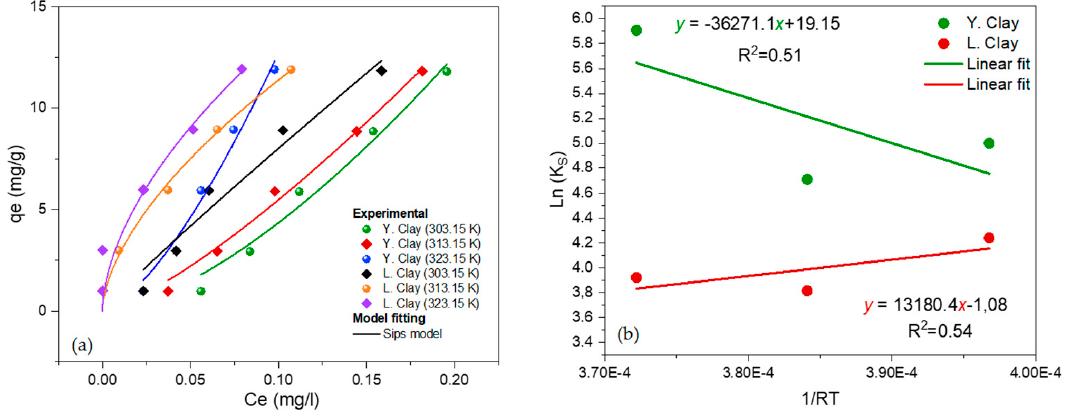
Figure 11. ( a ) effect of temperature on clay adsorption capacities ( V solution = 50 mL, m Clay = 50 mg, naturel pH, 200 rpm of stirring); ( b ) Plot for the thermodynamic analysis.